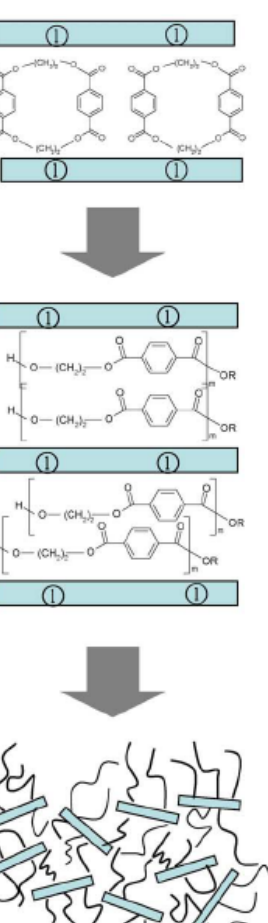
Figure 17. Ring opening polymerization of cyclic oligomers to generate polymer nanocomposites. 1 in the figure represents the layered silicate material. Reproduced from reference [72] by permission from